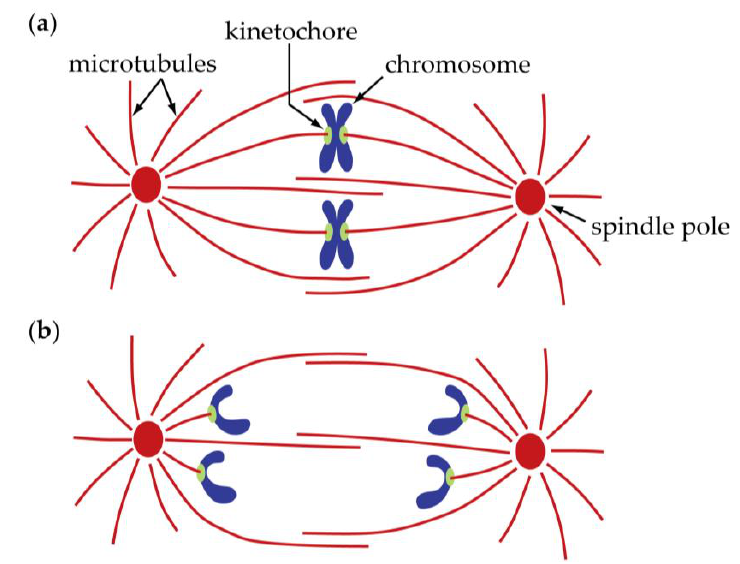
Figure 1. Schematic diagram of a spindle in metaphase ( a ) and anaphase ( b ). Only the chromosome-to-pole, “anaphase A” motion is depicted here; it is the focus of this chapter. Separation of the two spindle poles from one another via elongation of the spindle, “anaphase B”, is discussed in the subsequent chapter by Scholey et al. [3].